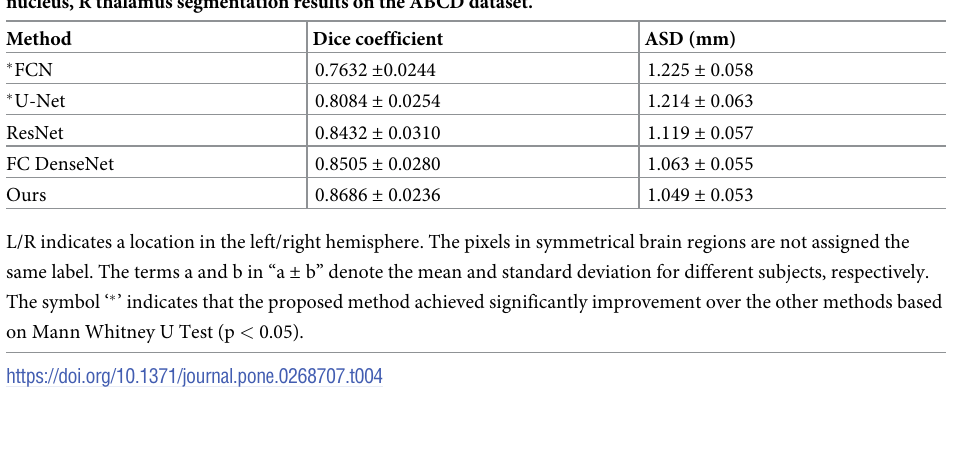
Table 4. Comparison of L inferior frontal gyrus—opercular, L inferior frontal gyrus–triangular, L inferior frontal gyrus—orbital, L hippocampus, L amygdala, L caudate nucleus, L thalamus, R inferior frontal gyrus–opercular, R inferior frontal gyrus–triangular, R inferior frontal gyrus—orbital, R hippocampus, R amygdala, R caudate nucleus, R thalamus segmentation results on the ABCD dataset. Method